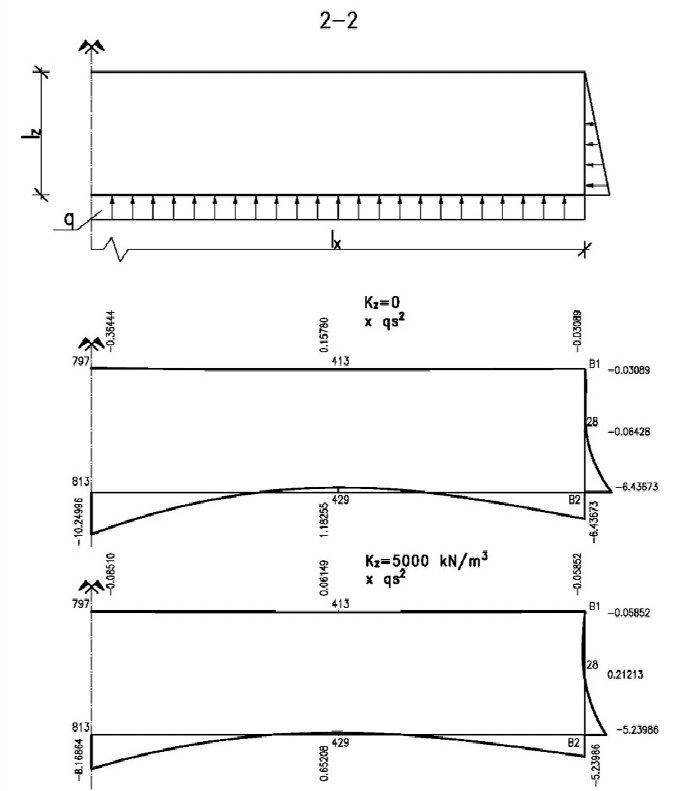
Figure 6. Charts of bending moments due to the hydrostatic load of the walls and the uniform load of the bottom without taking into account the effect of an elastic substrate and for the Poisson’s ratio ν = 0 and taking into account the effect of an elastic substrate K = 5000 kN/m 3 and for the Poisson’s ratio ν = 0 in cross section 2–2 (Figure 4). The internal partition lies in the symmetry axis.